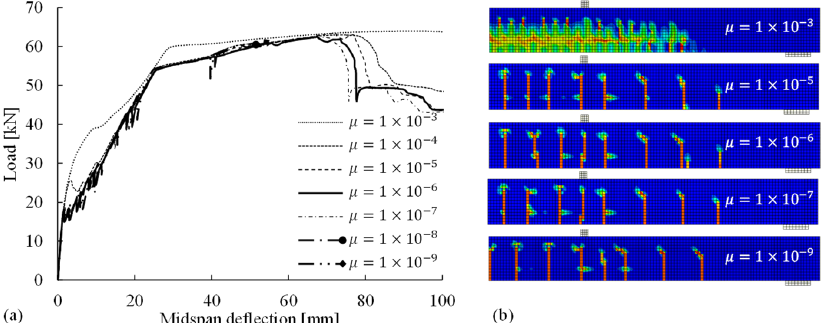
Figure 11. Numerical results: ( a ) load–midspan deflection relations; ( b ) crack patterns in the RC beam given the viscosity parameter µ ranging from 10 − 3 to 10 − 9 .